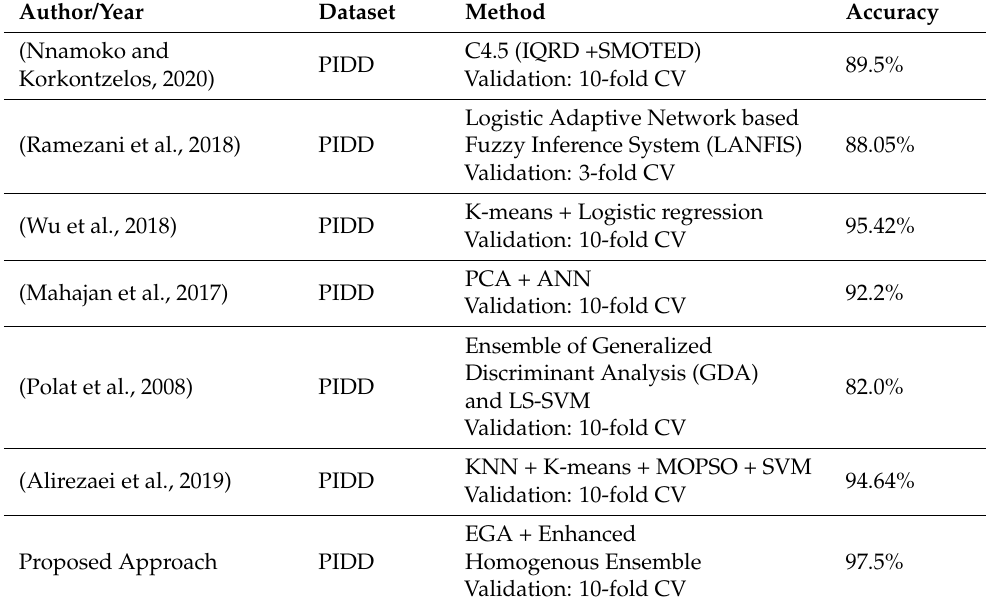
Table 6. Comparison of our proposed ensemble technique with other recently published